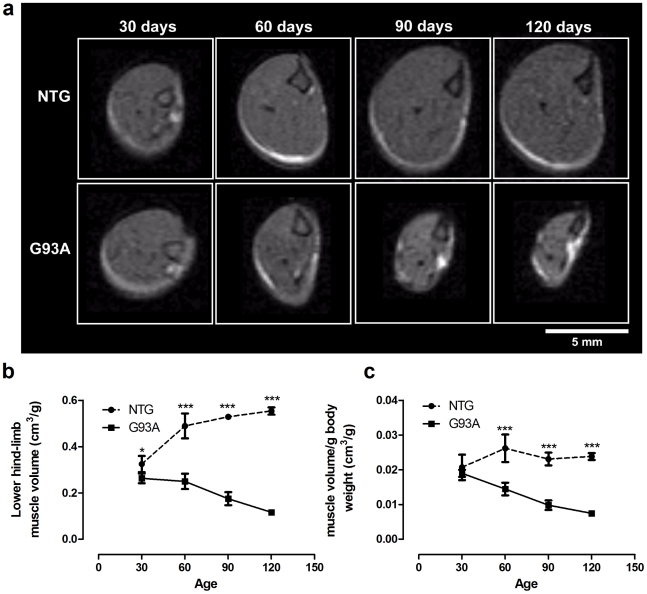
MRI detects muscle atrophy in SOD1G93A transgenic mice.T2 weighted structural scans of hindlimb at 30, 60, 90, 120 days of age (a) were used to calculate lower limb volume (knee to ankle), n = 5 per group (b), which was significantly reduced in SOD1G93A transgenic mice compared to non-transgenic (NTG) littermates at all timepoints (p<0.05 at 30 days, p<0.001 at 60, 90, 120 days, two way ANOVA with Bonferroni post test). The change in lower limb muscle volume as a function of weight (c) is also shown, indicating the initial difference in muscle volume observed at day 30 may be due to the smaller size of the SOD1G93A transgenic mice.